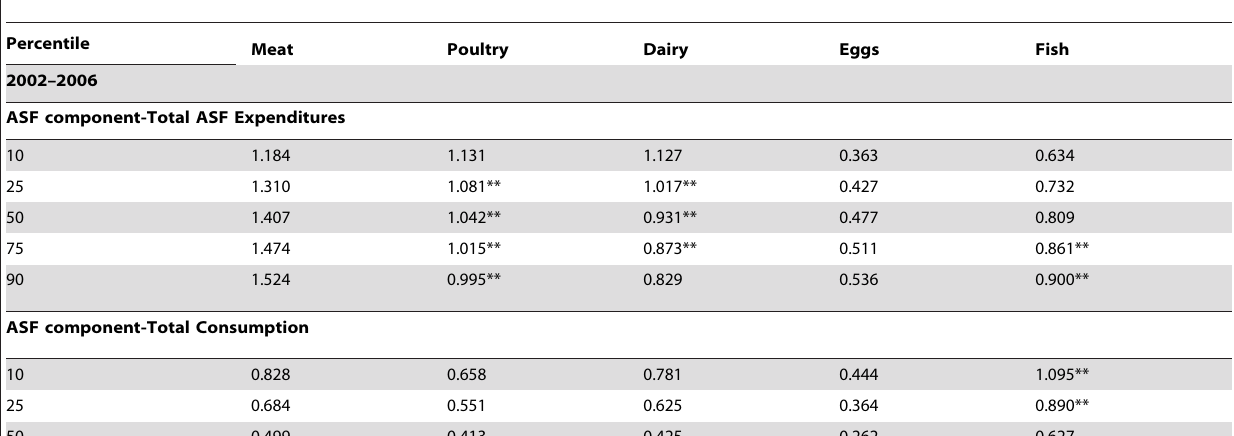
Table 4. Elasticities of ASF components with reference to ASF expenditures and total expenditures at specified percentiles of total expenditures. a